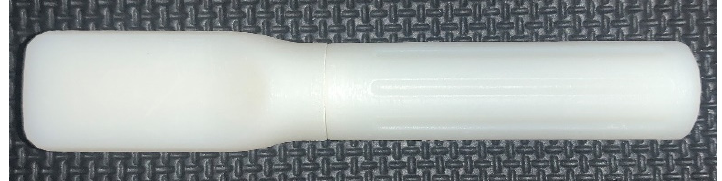
Figure 3. Concept B modified swab.